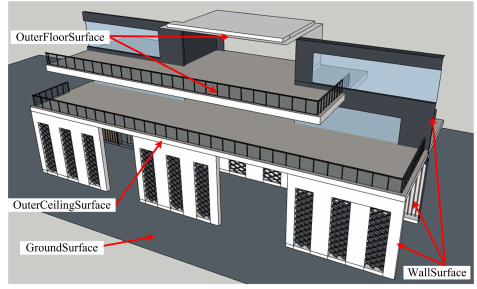
Figure 9. Simplified 3D model with top-bounded structures only.